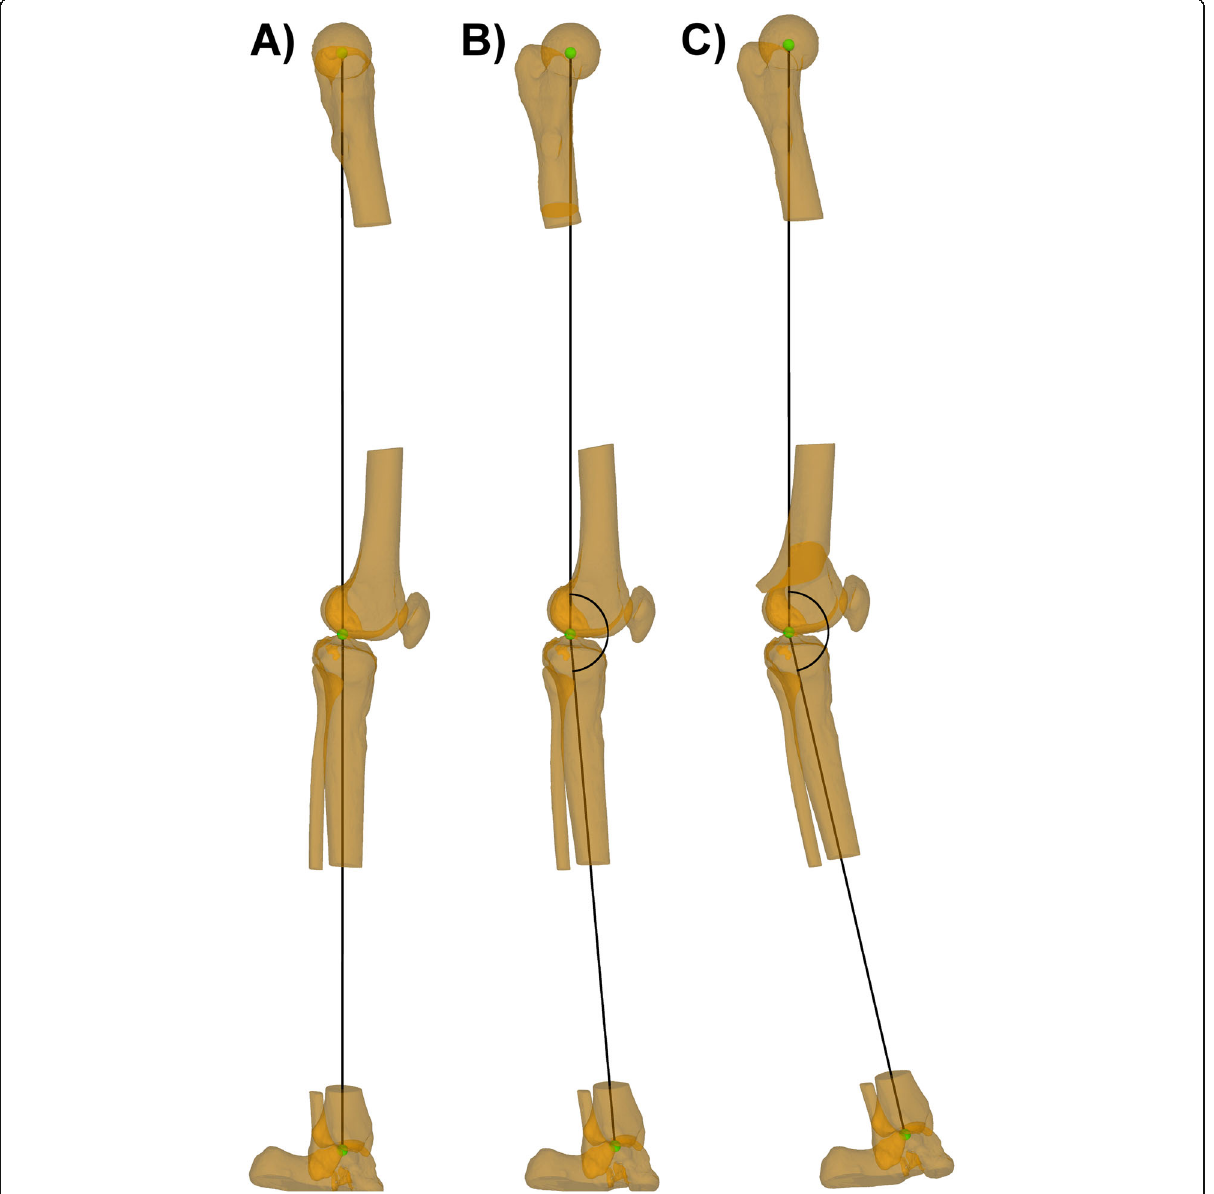
Fig. 4 Measurement of the sagittal mechanical leg axis. a Starting position with a neutral alignment. b 30° of internal rotation in Model 2 after osteotomy with a mal-angulation of the subtrochanteric osteotomy plane of + 30° in the frontal plane. c 30° of internal rotation in Model 2 after osteotomy with a mal-angulation of the supracondylar osteotomy plane of + 30° in the frontal plane. Schematically marked is the measurement of the altered sagittal mechanical leg